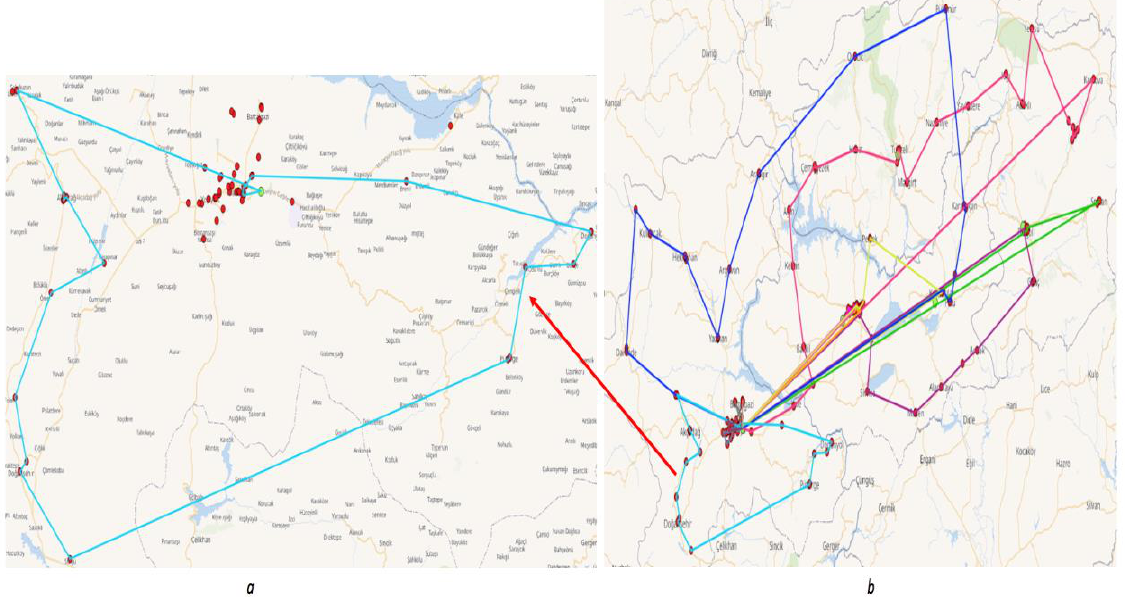
Figure 5. The best solution among 5 alternatives. a) Detail of one sub-route b) starting and finishing point for all sub-routes with different